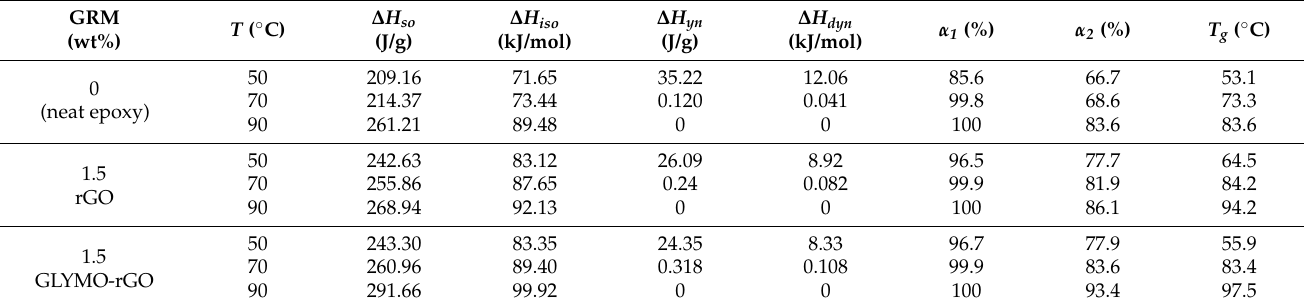
Table 4. Exothermic heat of curing during the isothermal scans ( ∆ H iso ), during subsequent dynamic scans ( ∆ H dyn ), degree of curing ( α ) and glass transition temperature ( T g ).